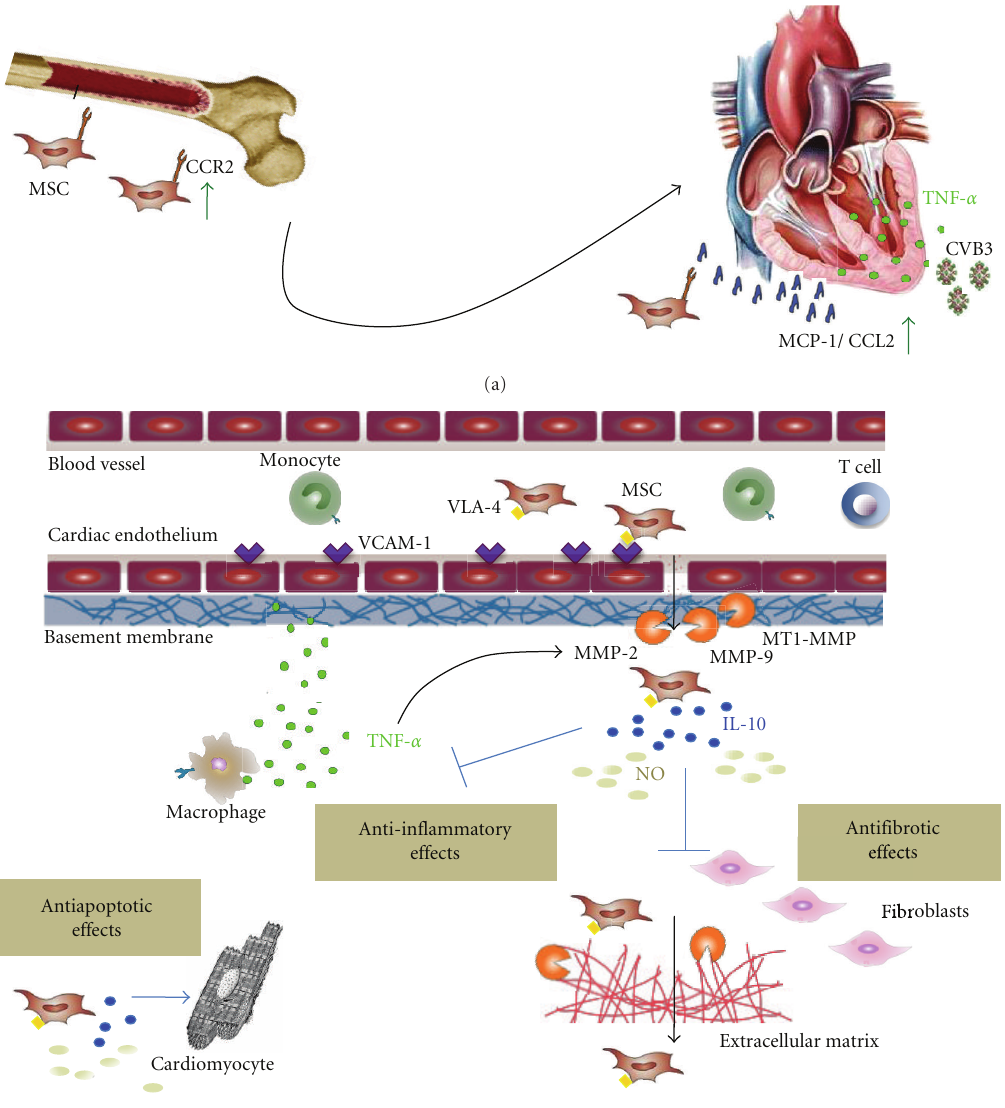
Figure 1: Proposed pathways how inflammation induces cardiac homing of mesenchymal stem cells. (a) TNF- α and/or Coxsackievirus B3 (CVB3) trigger the induction of cardiac expression of monocyte chemoattractant protein-1 (MCP-1) also known as CCL2. At the same time, the expression of the corresponding chemokine receptor CCR2 is induced on mesenchymal stem cells (MSCs), stimulating cardiac migration. (b) TNF- α induces vascular cellular adhesion molecule- (VCAM-)1 expression on the cardiac endothelium. The VLA-4/VCAM-1 axis is important for firm MSC adherence to endothelial cells. Next, MSCs transmigrate through the endothelium which also requires the interaction of VCAM-1 and VLA-4. Finally, MSCs invade through the basement membrane and the extracellular matrix (ECM) via their secretion of matrix metalloproteinase- (MMP-)2, MMP-9, and membrane type 1 MMP (MT1-MMP), which are upregulated by TNF- α . In the heart, MSCs can exert cardioprotective e ff ects, including their anti-inflammatory, antifibrotic, and antiapoptotic features, among others, via interleukin- (IL-)10 and nitric oxide